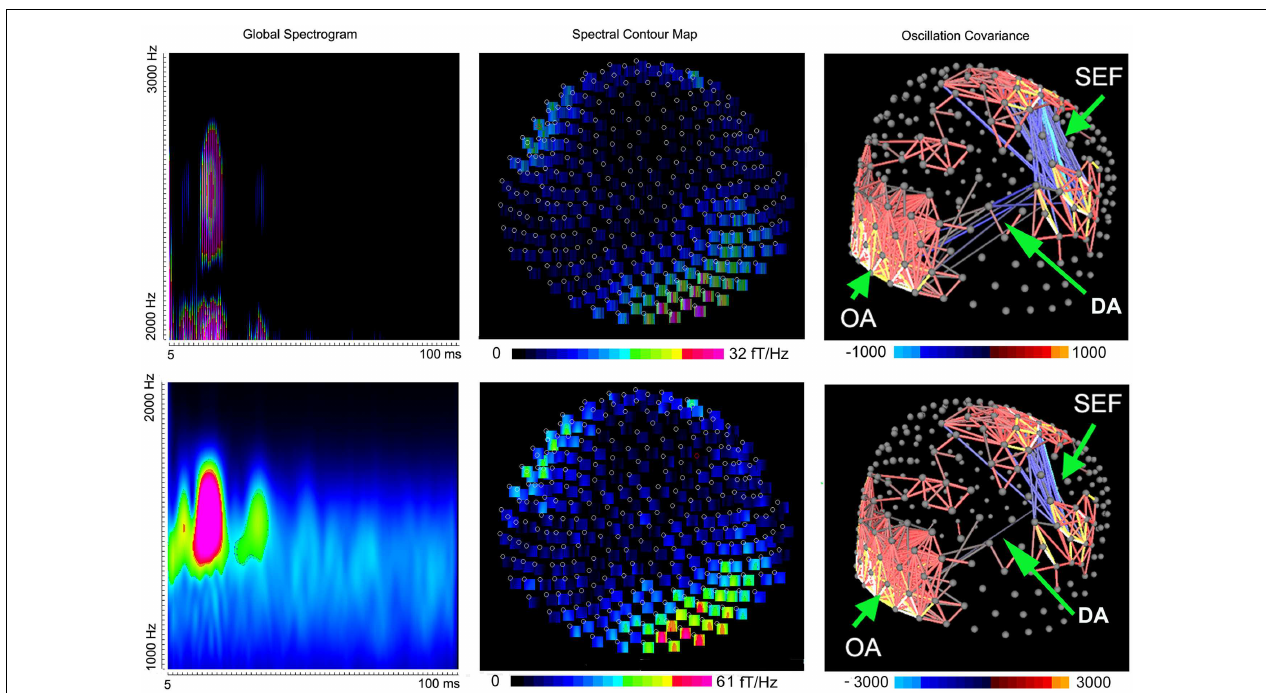
Mathematically, signals in these “dipolar sensors” are well-correlated and produce a strong oscillation covariance. “SEF” indicates somatosensory evoked magnetic fields; “DA” indicates deep brain activation; “OA” indicates occipital